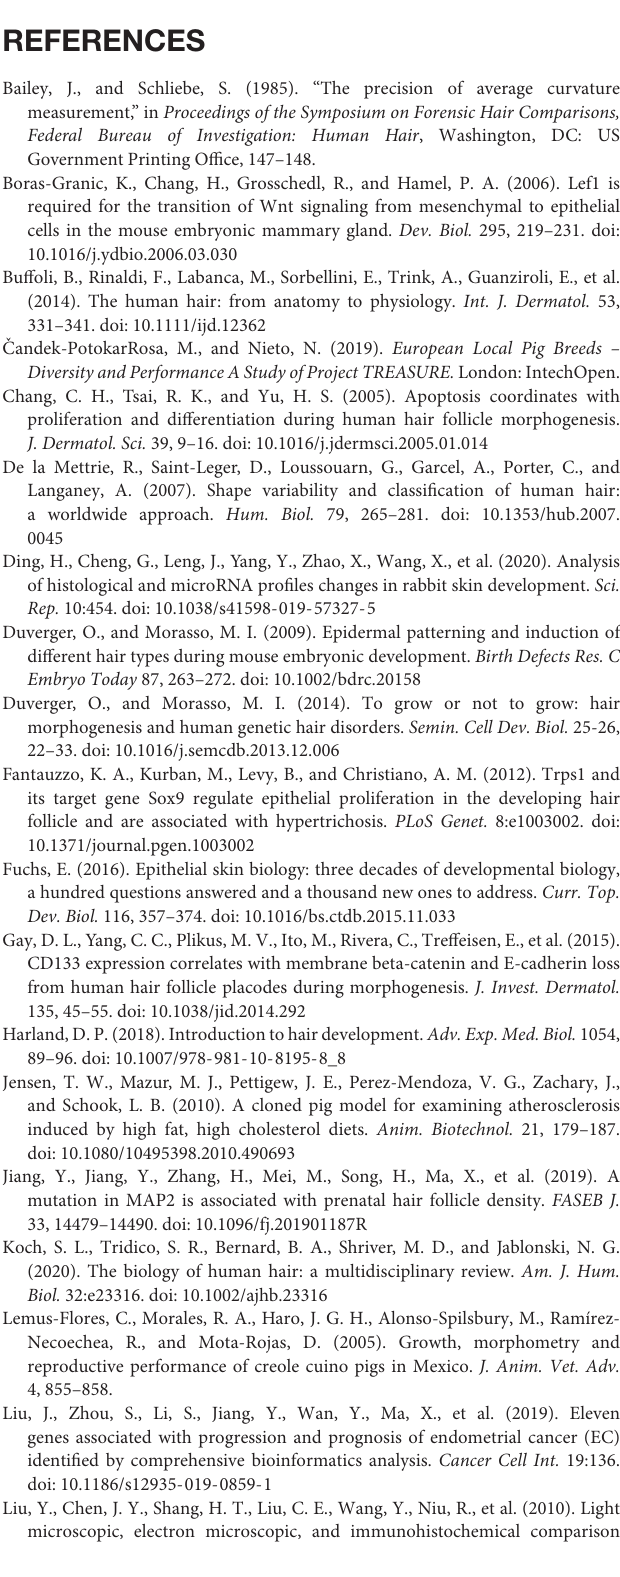
arrow represents the (1) outer root sheath, ORS; (2) inner root sheath, IRS; (3) hair shaft; (4) dermal papilla, DP. The red dotted line represents the critical period of hair follicle morphogenesis development; Scale bars, 200 µ